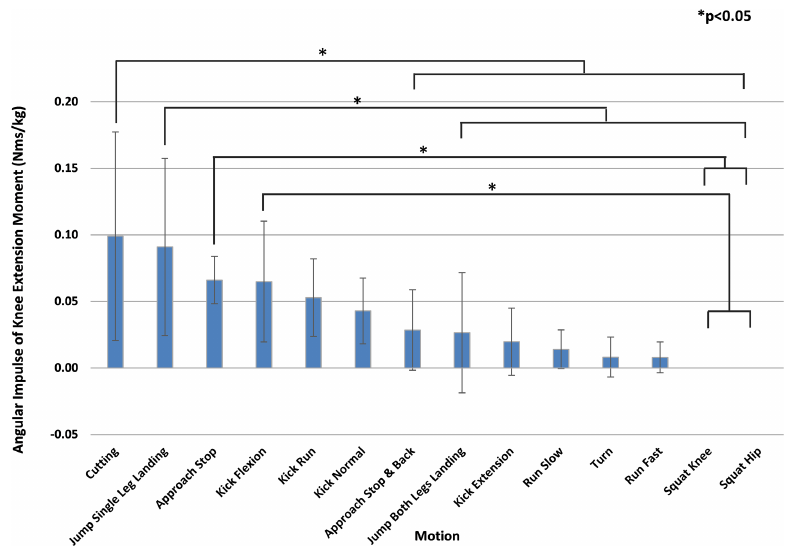
Fig 4. Motion comparison by averageangular impulse of the knee extension moment (2.0 Nm/kg or greater). Mean values are shown in descendingorder from left to right. "Cutting"was significantly greater than 8 types of motion. Multiplecomparisons were performed after ANOVA to show statisticallysignificant differences betweenmotions. * P < 0.05.